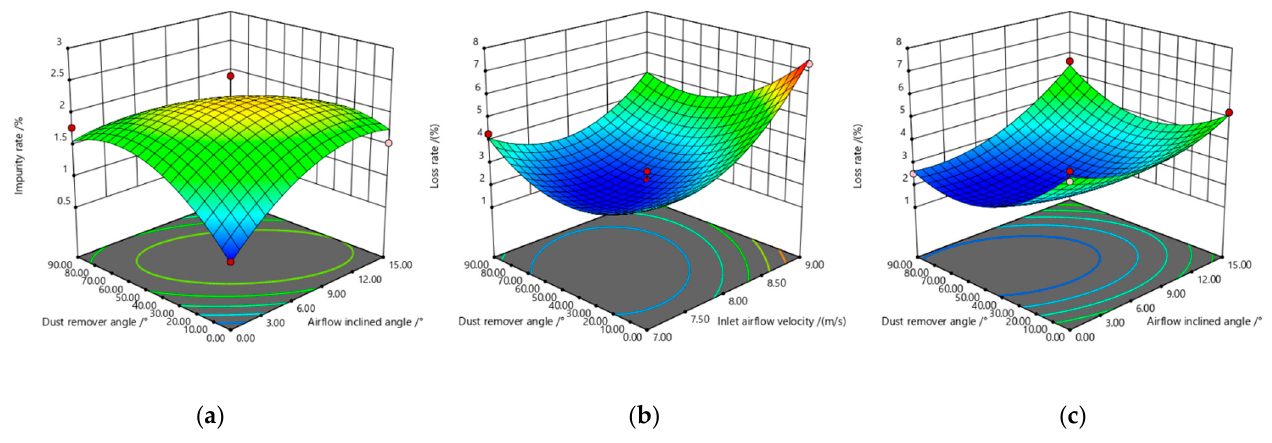
Figure 21. Influence of interactive factors on the impurity rate and loss rate.